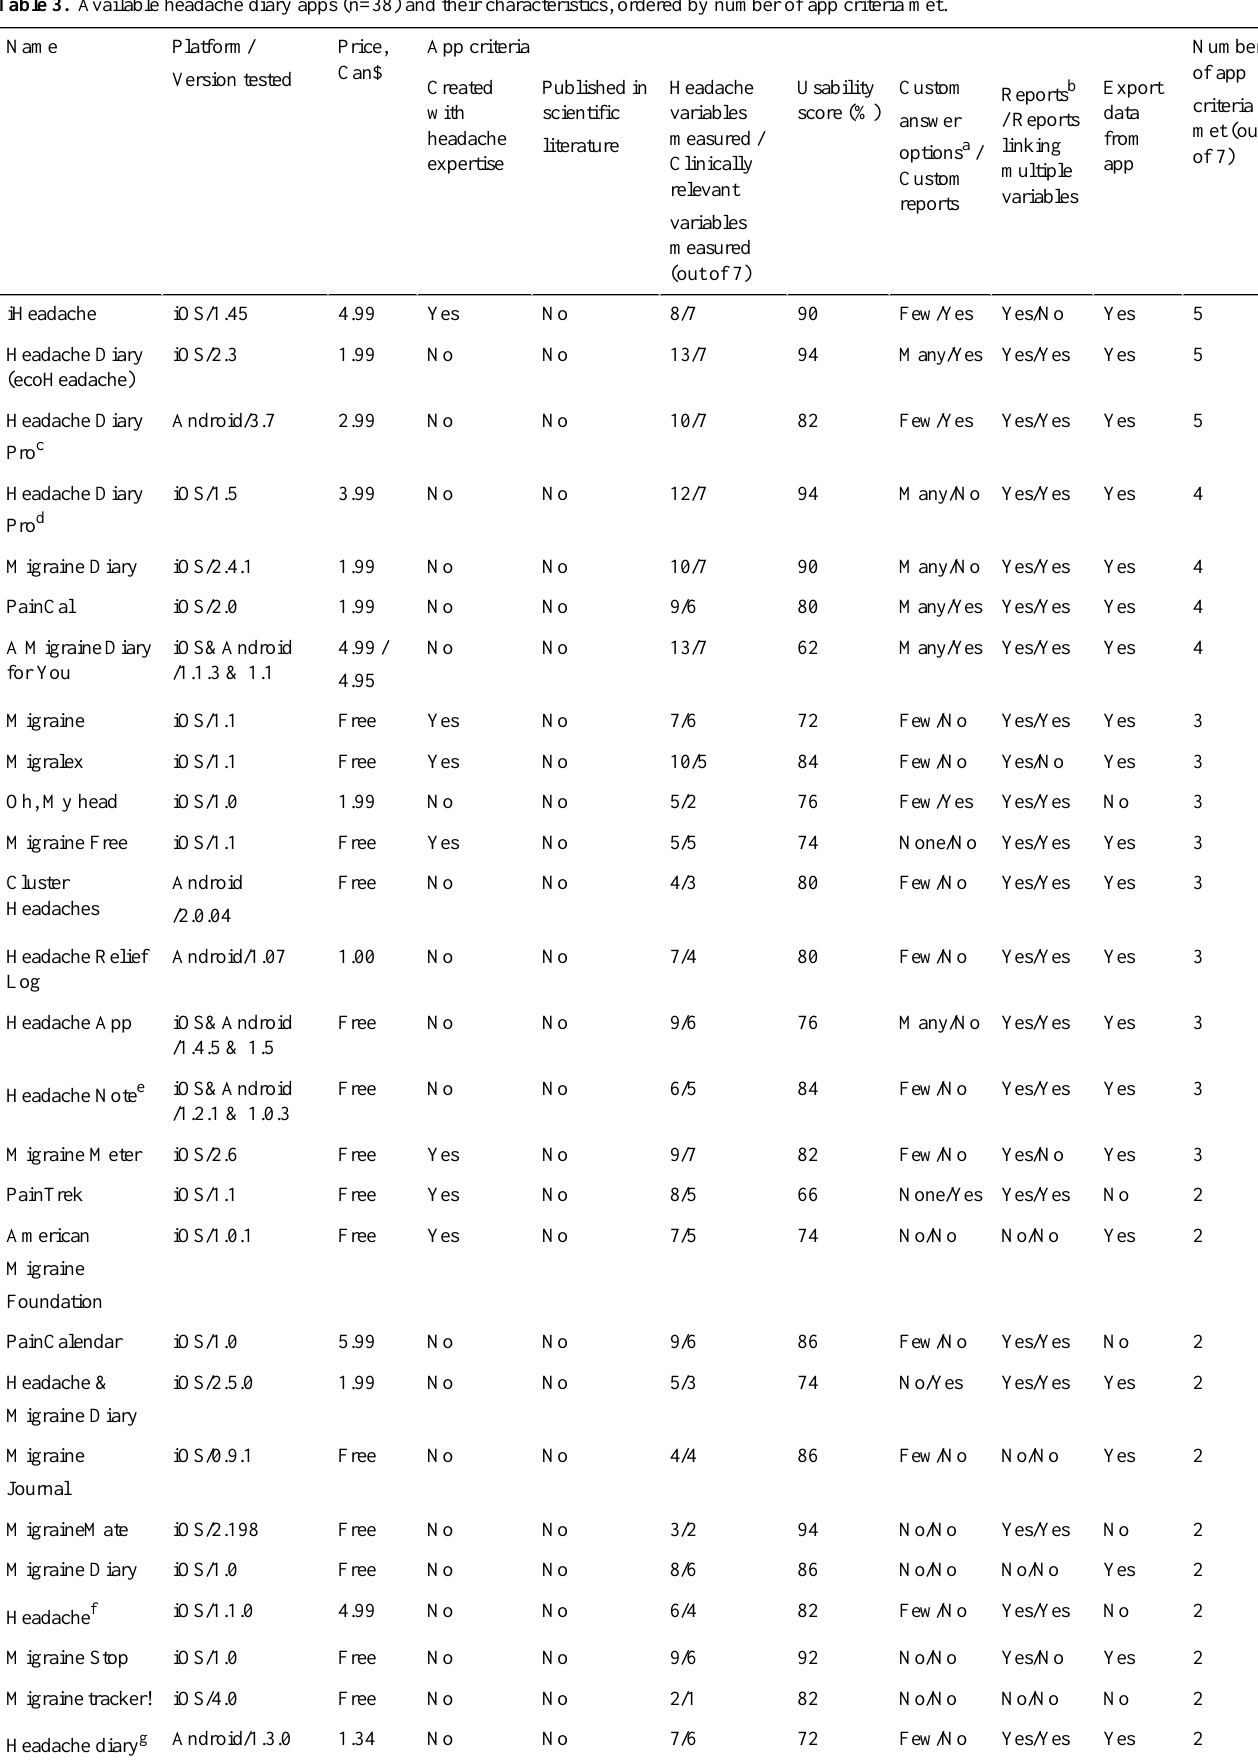
Table 3. Available headache diary apps (n=38) and their characteristics, ordered by number of app criteria